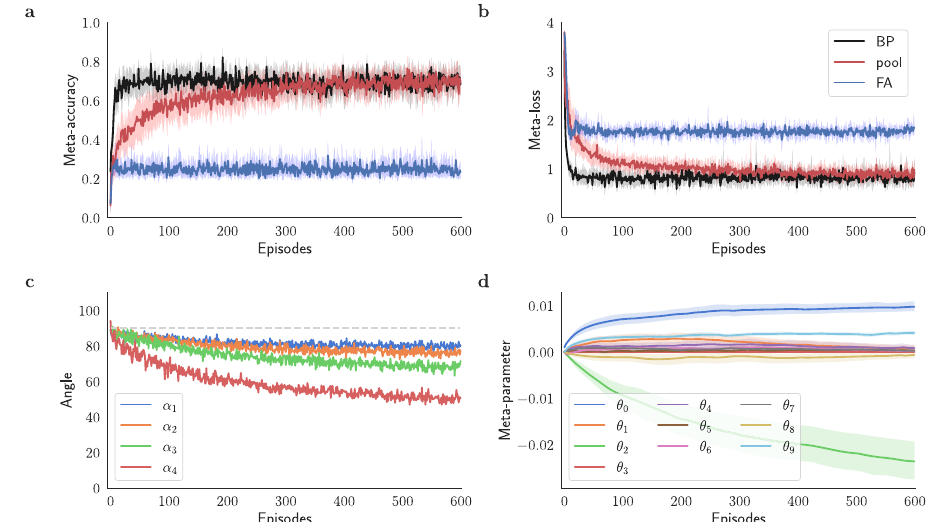
Fig. 4 | Meta-learning biologically plausible plasticity rules. Performance of a classi fi er network trained with a pool of biologically plausible plasticity rules F pool (pool)through fi xedfeedbackpathways. a Meta-accuracyand b meta-lossfor F pool comparedto F 0 viafeedbackalignment(FA)andbackprop(BP).Whilelearningby F pool initially resembles F 0 , continued meta-optimization raises accuracy. This increase re fl ects the discovery of plasticity terms that can improve learning with random feedback pathways to level with the backprop method in the given